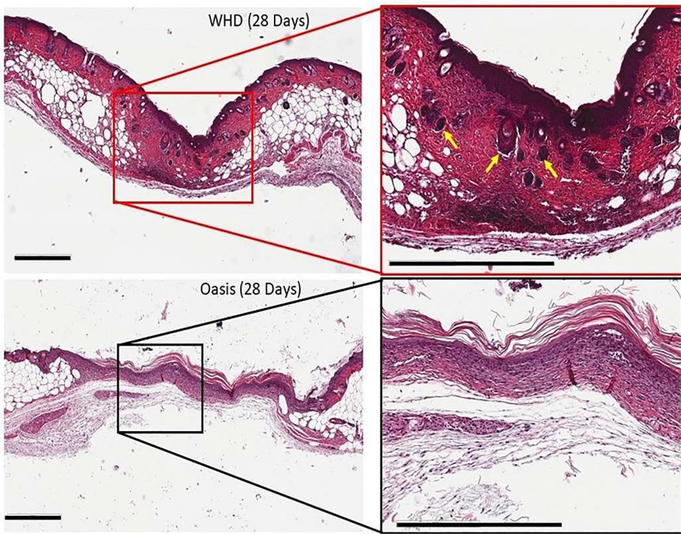
Hematoxylin and Eosin stained samples from WHD and Oasis Wound Matrix-treated wound sites after 28 days of remodeling. WHD-treated wound sites demonstrated wound regeneration where the skin organ and tissue had evidence of functional restoration with the presence of hair follicles (yellow arrows). Scale bars = 600 μm.